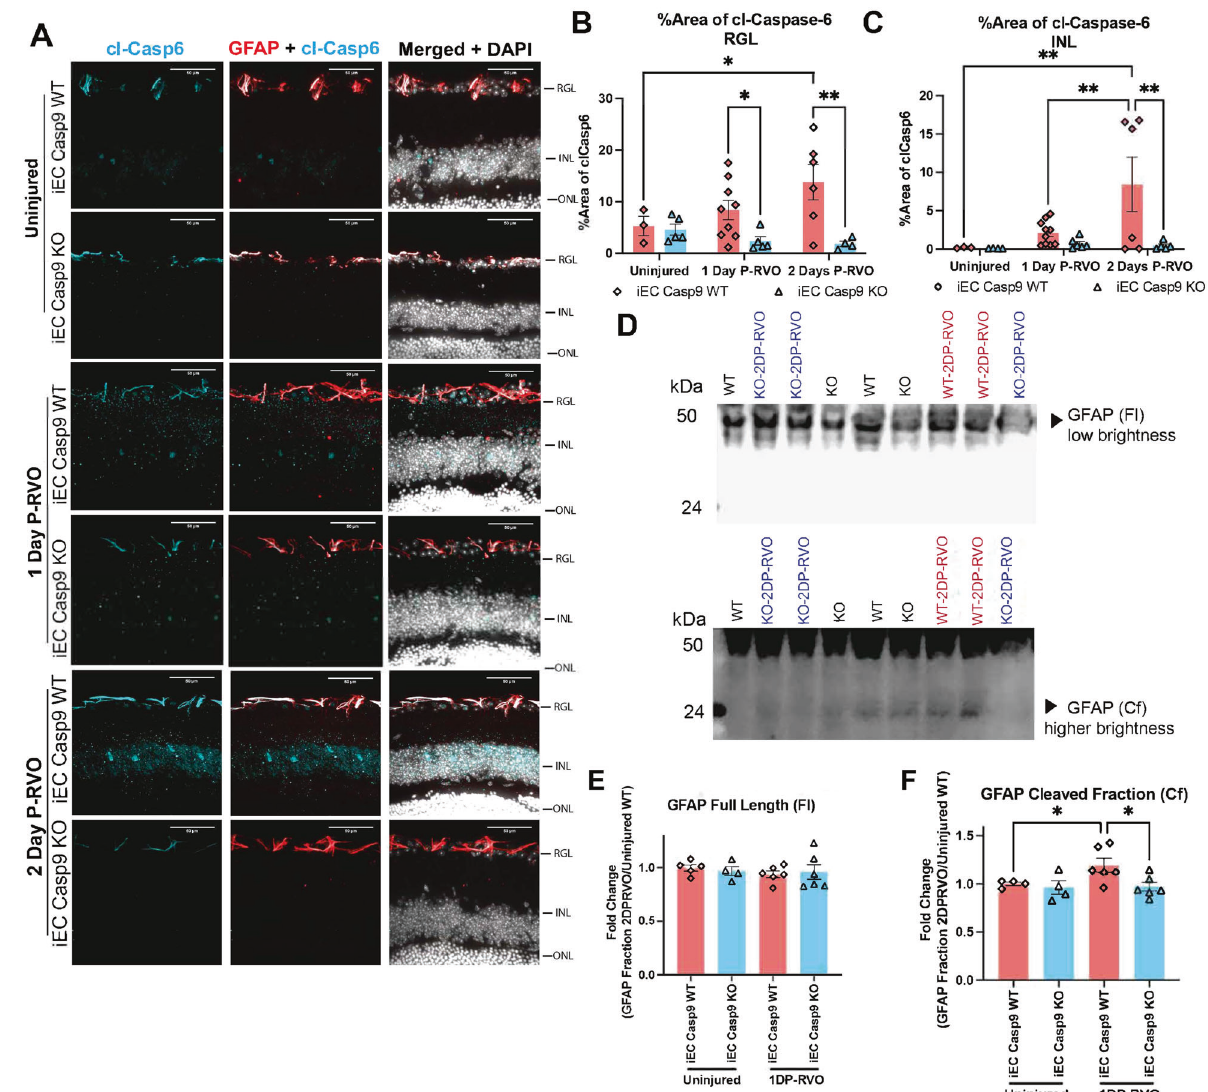
Fig. 5 EC Casp9 deletion promotes astroglial decrease in cl-caspase-6 levels and caspase-6 GFAP cleavage P-RVO. A Retinal cross-sections from one and two days P-RVO iEC Casp9 WT and KO mice were stained with cl-caspase-6 (cyan), GFAP (red), co-localization of cl-Casp6 and GFAP (white), and DAPI (white). Scale bar = 50 µm. B Percent area of expression of cl-caspase-6 in RGL and NFL of uninjured iEC Casp9 WT ( n = 3) and KO ( n = 5), one day P-RVO iEC Casp9 WT ( n = 9) and KO ( n = 6), and two days P-RVO iEC Casp9 WT ( n = 6) and KO ( n = 4). C Percent area of expression of cl-caspase-6 in INL of uninjured iEC Casp9 WT ( n = 3) and KO ( n = 5), one day P-RVO iEC Casp9 WT ( n = 10) and KO ( n = 6), and two days P-RVO iEC Casp9 WT ( n = 6) and KO ( n = 5). D Percent area of expression of GFAP in RGL and NFL of uninjured iEC Casp9 WT ( n = 3) and KO ( n = 4), one day P-RVO iEC Casp9 WT ( n = 9) and KO ( n = 5), and two days P-RVO iEC Casp9 WT ( n = 4) and KO ( n = 6). E Percent area of expression of GFAP from ONL to IPL in iEC Casp9 WT ( n = 3) and KO ( n = 4), one day P-RVO iEC Casp9 WT ( n = 10) and KO ( n = 6), and two days P-RVO iEC Casp9 WT ( n = 4) and KO ( n = 5). Error bars mean ± SEM, Two-way ANOVA, Fisher ’ s LSD test. Retinal ganglion layer (RGL), inner nuclear layer (INL), and outer nuclear layer (ONL). F Western blot detection of GFAP in uninjured iEC Casp9 WT and KO and two days P-RVO iEC Casp9 WT and KO retinal lysates. G Quanti fi cation of GFAP full length 50 kDa band in uninjured iEC Casp9 WT ( n = 5, biological replicates) and KO ( n = 4, biological replicates) and two-days P-RVO WT ( n = 6, biological replicates) and KO ( n = 6,